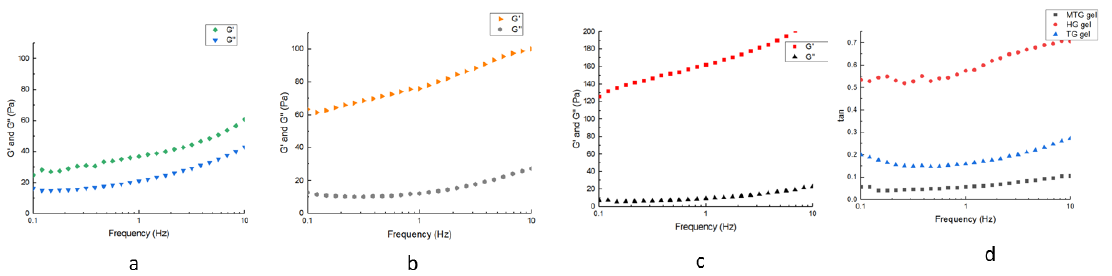
Figure 7. G’ and G" of different gels. Note: ( a ) for HG gels; ( b ) for TG gels; ( c ) for MTG gels; ( d ) for tan δ.